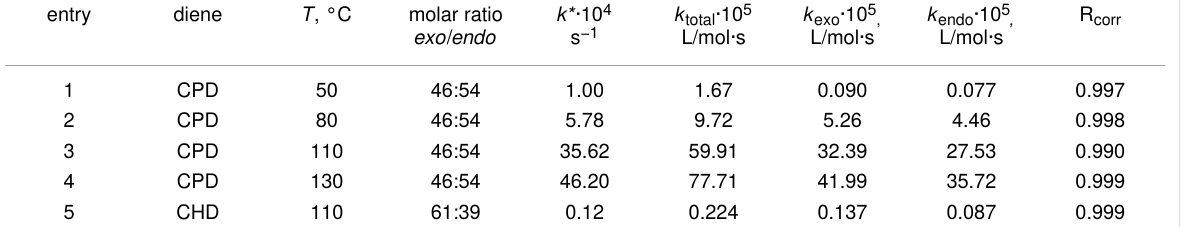
Table 1: Kinetic parameters for the reactions of 1h with CPD and